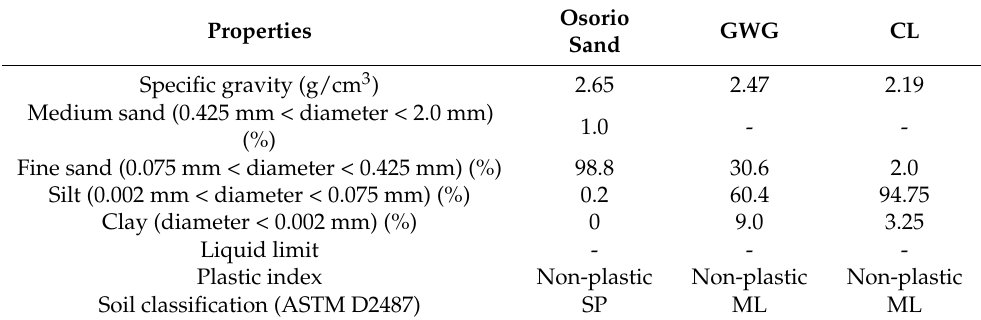
Figure 1. Particle size distribution of ground waste glass, carbide lime and Osorio sand. Table 1. Physical properties of the Osorio sand, ground waste glass and carbide Table 2. Composition of the ground waste glass and carbide lime (wt %) .